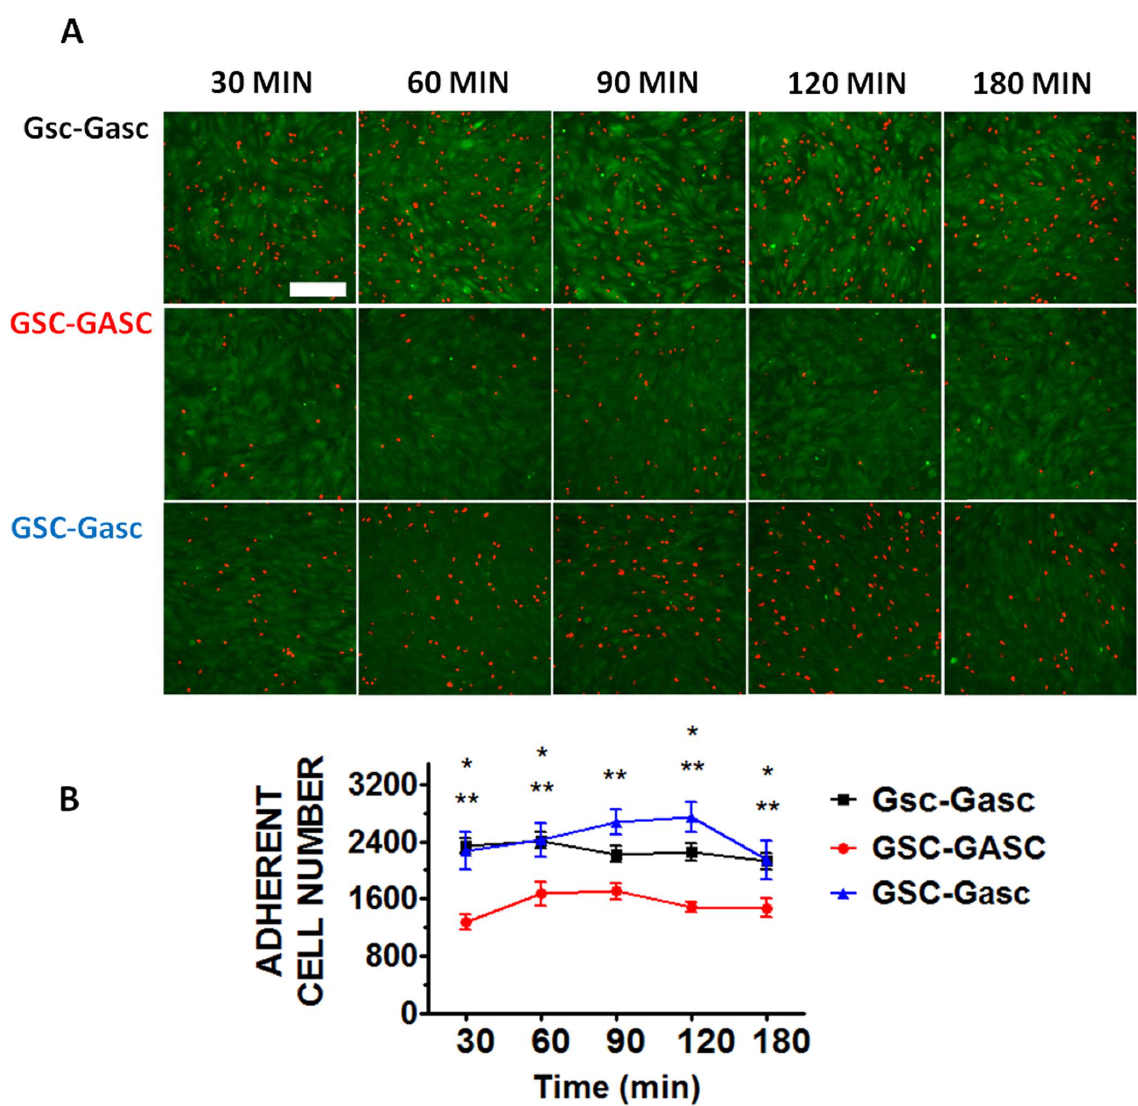
Figure 1. Co-culture of GSC on GASC, Gsc on Gasc and GSC on Gasc. ( A ) Fluorescence images of Hoechst-labeled glioma-initiating cells (red color) on CFSE-labeled glioma associated cells (green color) at different time point (scale bar 200 m m). ( B ) Quantitative analysis of the number of GSC adherent to GASC (red line), Gsc adherent to Gasc (black line) and GSC adherent to Gasc (blue line), respectively. Cell type: p , 0.0001, time: p=0.09. Data are presented as mean 6 standard error. *, p , 0.05 of GSC-GASC vs Gsc-Gasc; **, p , 0.05 of GSC-GASC vs GSC-Gasc.